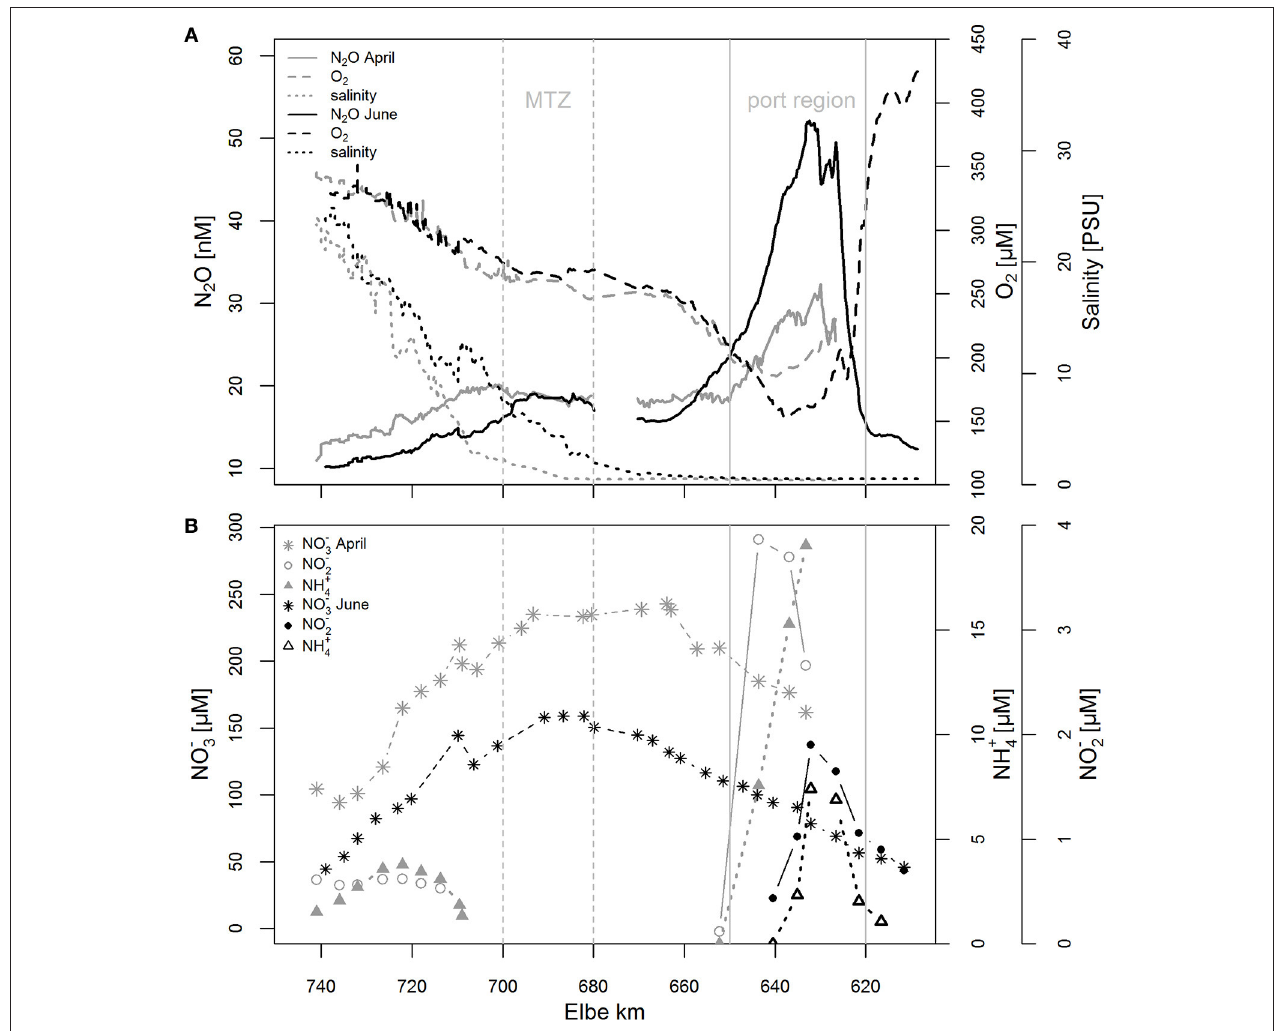
FIGURE 3 | Transect measurements in April 2015 and June 2015 from Elbe stream km 609 to 745. (A) Continuous measurements of N 2 O, O 2 and salinity, (B) Concentrations of DIN: NO − 3 , NH + 4 , and NO − 2 ; vertical lines indicate the Hamburg port region according to Figure 1 , the dashed line localized the area of the